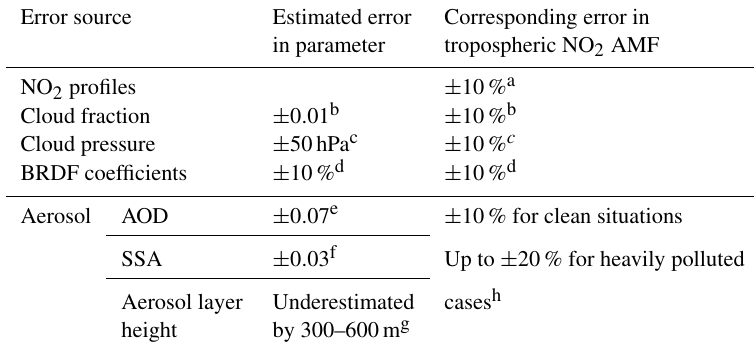
Table 4. Contributions of estimated errors in POMINO-TROPOMI NO 2